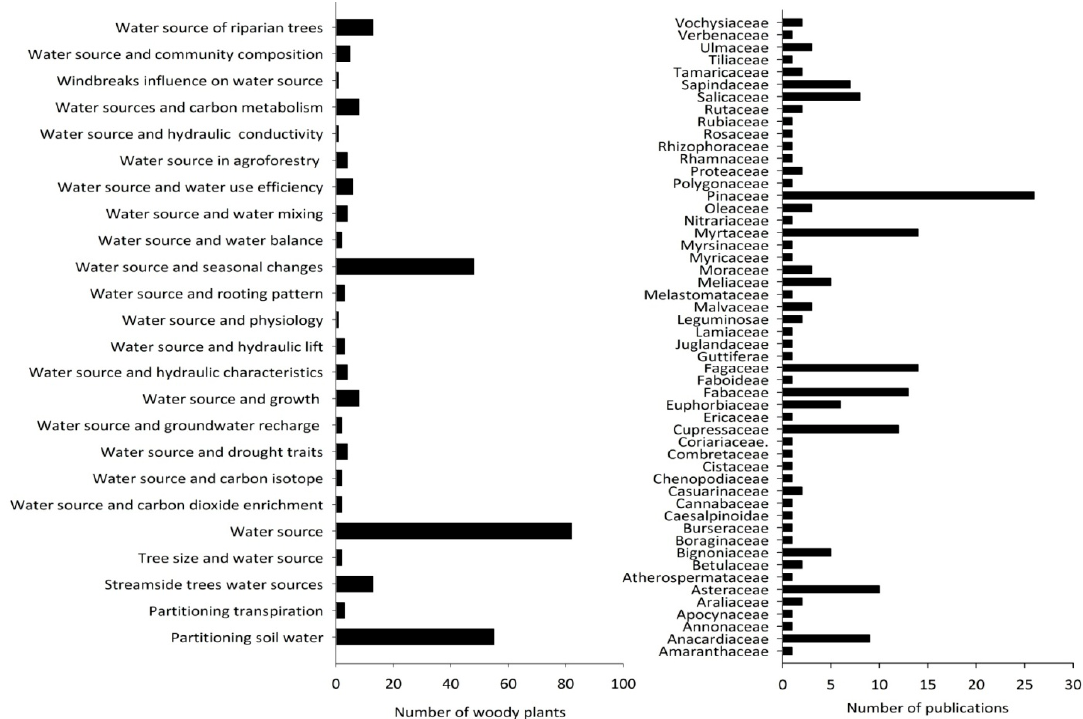
Figure 5. The right side bar graph represents the distribution of research focus among woody plant families (note: each publication may have more than one family). The left side bar graph indicates the research focus on woody plant water source.